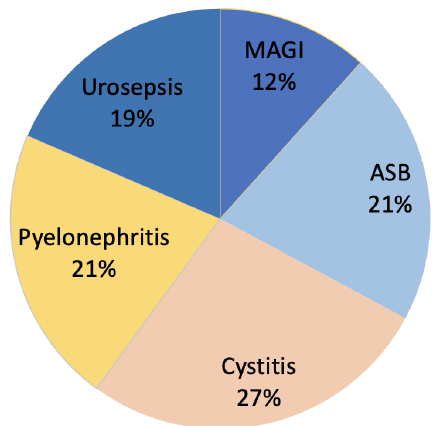
Figure 1: Type of HAUTIs according to the GPIU study 2003–2013 [29]; MAGI: male accessory gland infection, ASB: asymptomatic